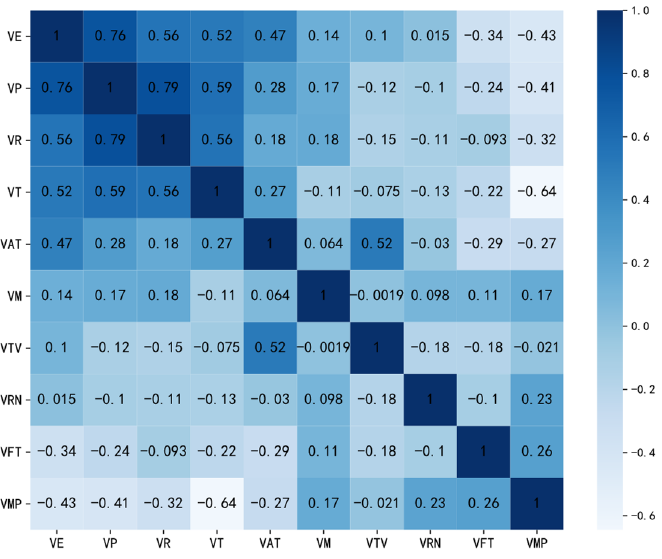
Figure 2. Heat map of lecture video viewing behavior.